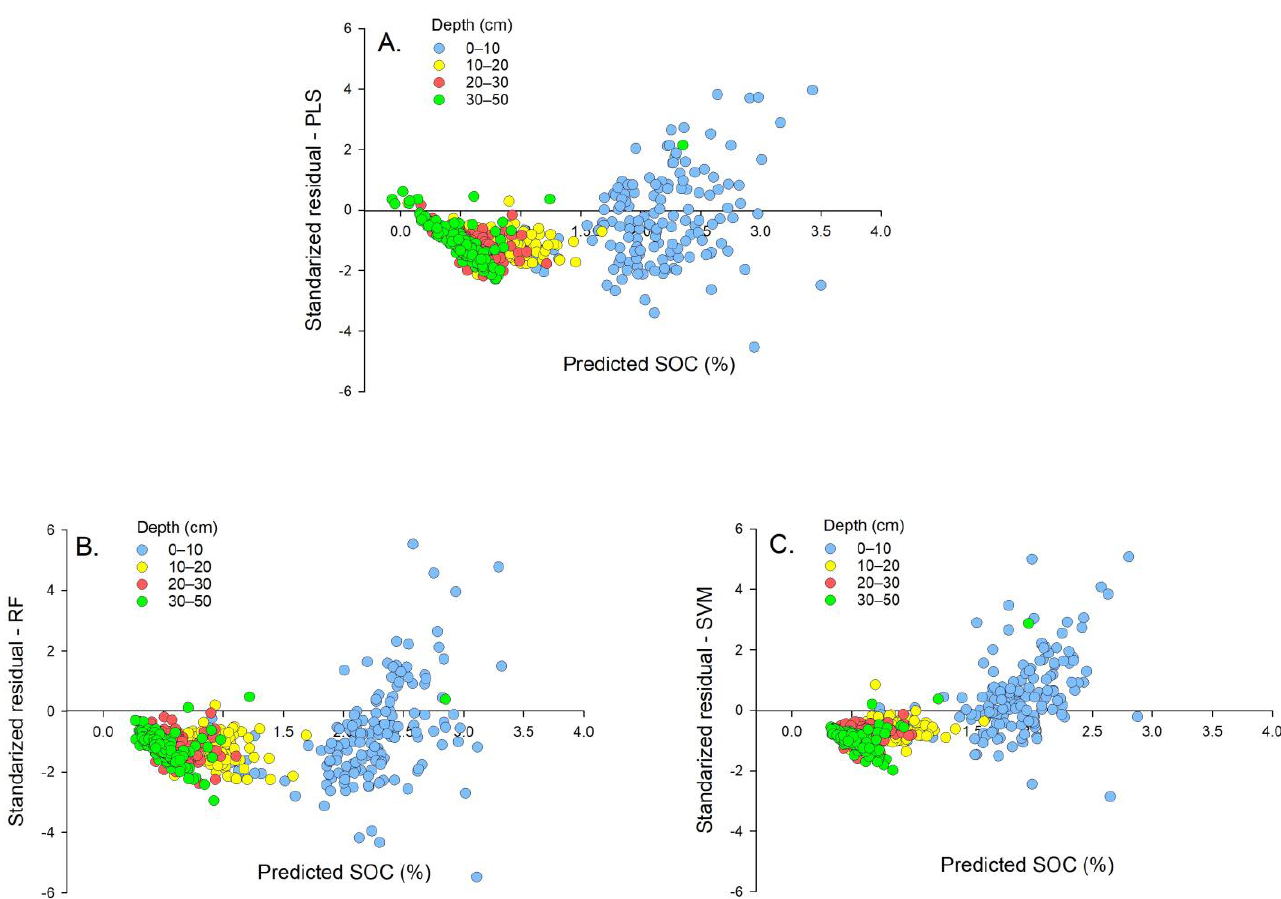
Figure 7. Effect of sampling depth on soil organic carbon (SOC) prediction using ( A ) partial least squares (PLS), ( B ) random forest (RF), and ( C ) support vector machine (SVM) models. The training dataset contains 400 samples. All standardized residuals (residual = measured − predicted) were then plotted against their predicted C content. If the calibration model is appropriate, the residuals should be distributed randomly around the y = 0 line.